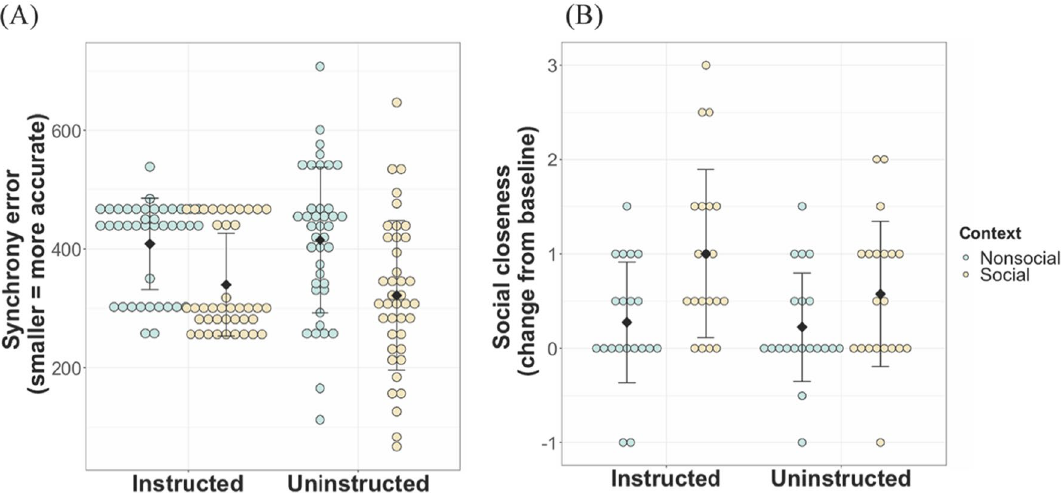
Figure 2. Synchronisation accuracy and social closeness by context and instruction conditions in adults. ( A ) Synchronisation accuracy per context and instruction condition. The y-axis shows mean RMS of the difference in inter-tap intervals between the participant and the stimulus, with higher scores indicating more errors and worse synchrony accuracy. ( B ) Social closeness per context and instruction condition. Mean change in closeness score (test-baseline), with higher scores indicating an increase in closeness as compared to baseline. Coloured dots indicate individual data points, black diamonds indicate group mean and whiskers indicate standard error of the